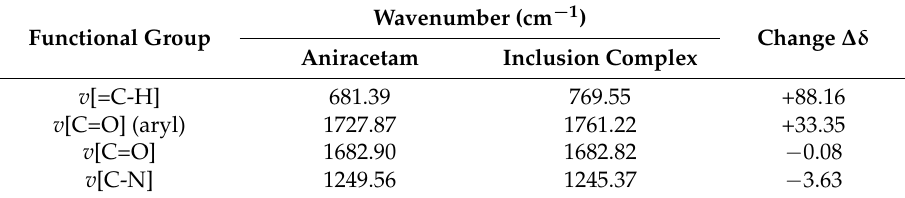
Table 3. Comparison between the FTIR spectra intensity of aniracetam and the inclusion complex. Functional